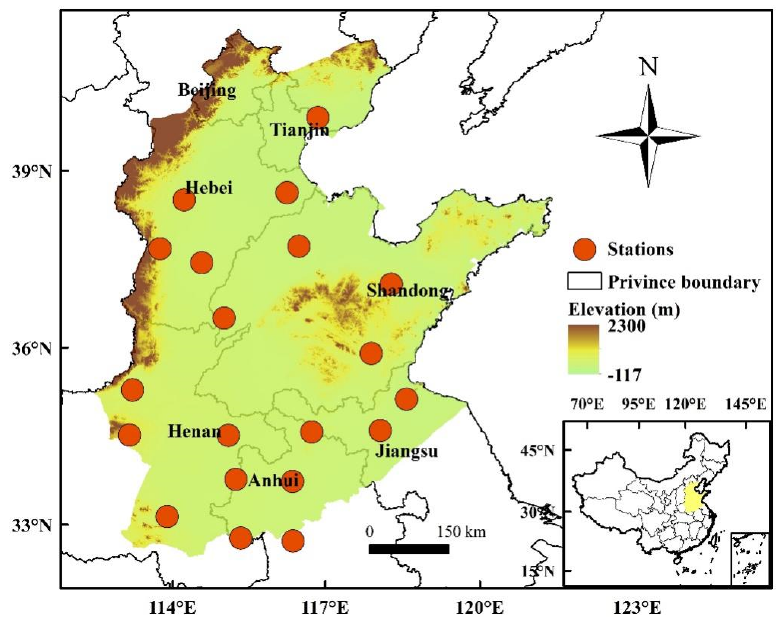
Figure 1. The spatial distribution of 20 agro ‐ meteorological sites across the North China Plain.